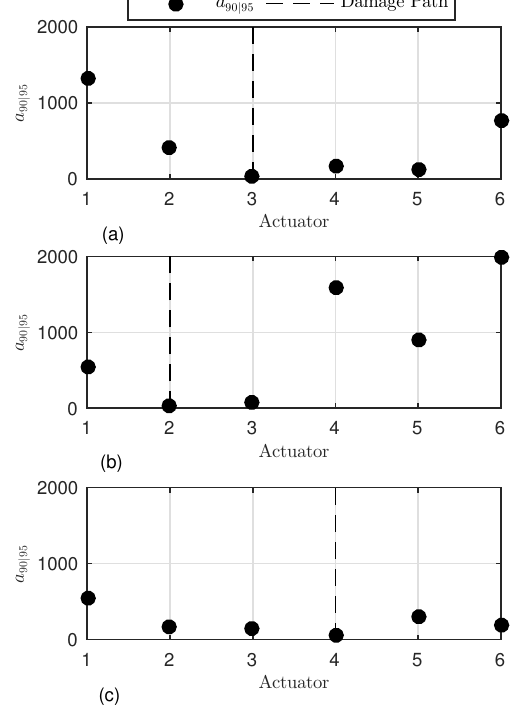
Figure 15. a 90 | 95 values versus interrogation path. The POD ( a ) is predicted along all vertical paths. Damage D1 ( a ), D2 ( b ), and D3 ( c ).